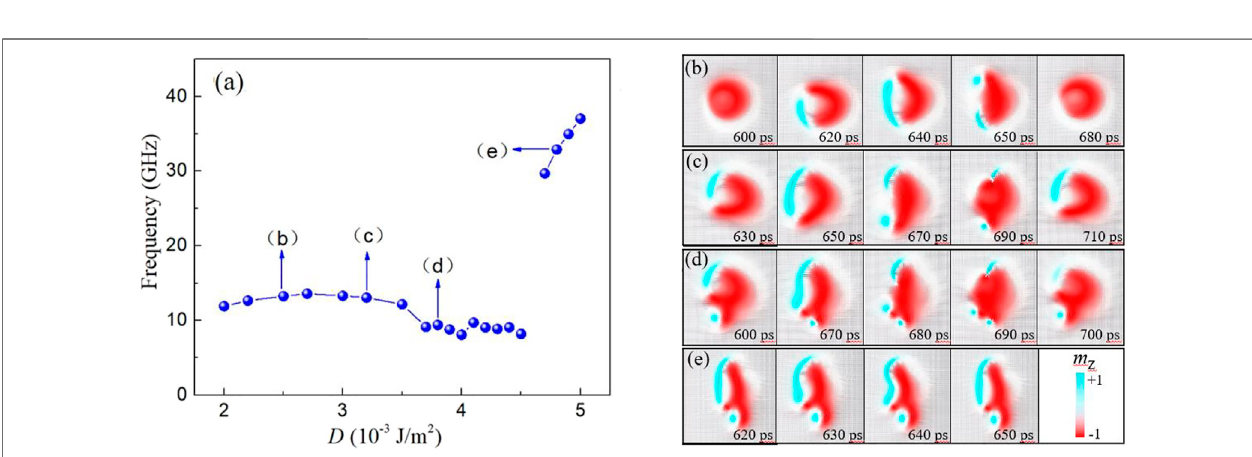
FIGURE4| (Coloronline.) (A) DependenceoftheoscillationfrequencyontheDMIstrength.Thecurrentdensityis fi xedto36×10 11 A/m 2 . (B – E) Thetimeevolution of the magnetization m z for different oscillation modes corresponding to different frequencies marked in (A) .